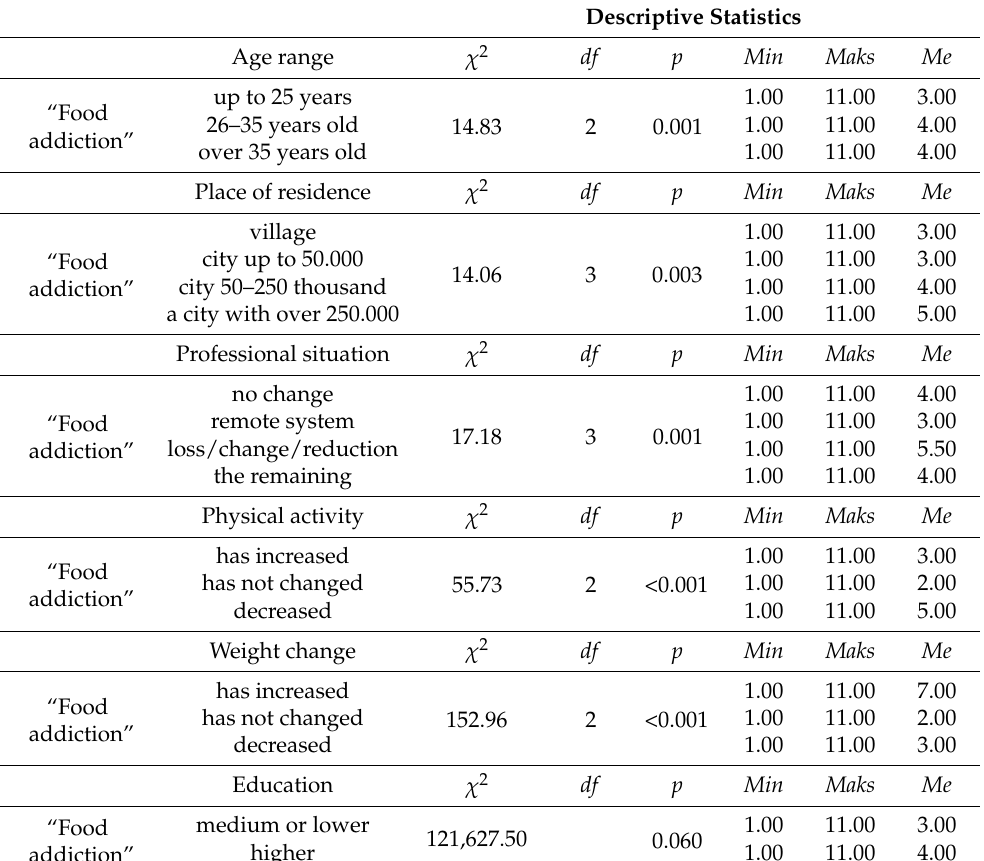
Table 5. Correlation between “food addiction” and age range, place of residence, professional situation, physical activity and weight change.